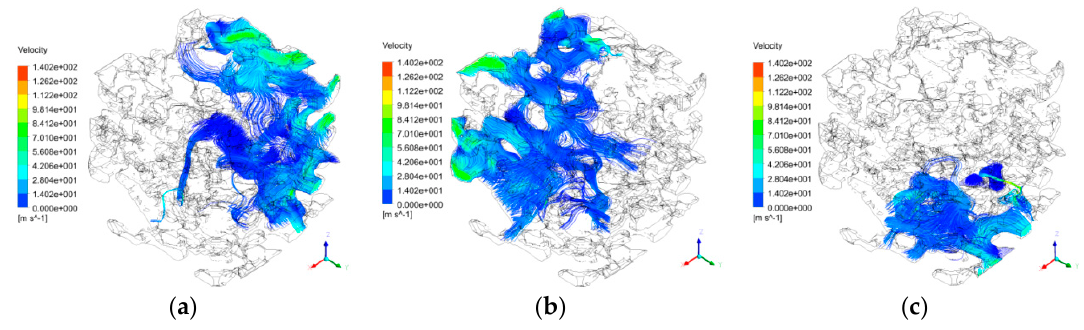
Figure 19. Seepage velocity distribution of multi-channel in the X , Y , and Z directions: ( a ) X direction; ( b ) Y direction; and ( c ) Z direction.